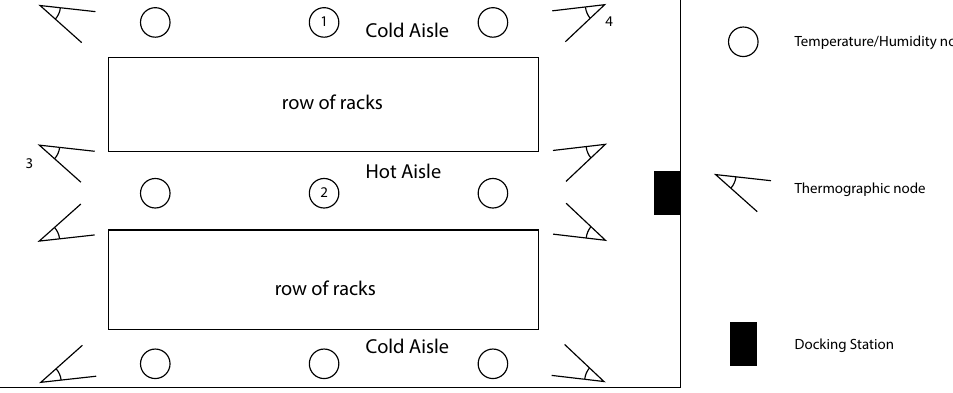
Figure 10. The data center layout and VSN nodes’ set-up. Triangles represent thermographic nodes, oriented in order to capture a thermographic image of half of the rack line’s side; circles represent temperature/humidity nodes, and rectangle represents the docking